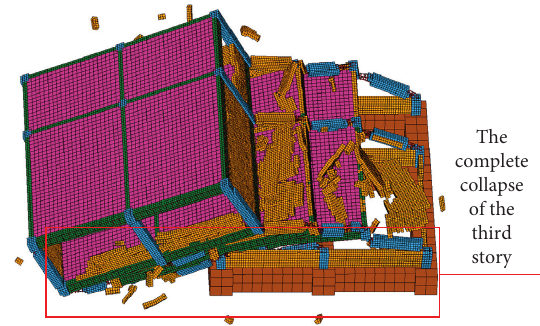
Figure 35: Third-floor collapse of the simulation (front).